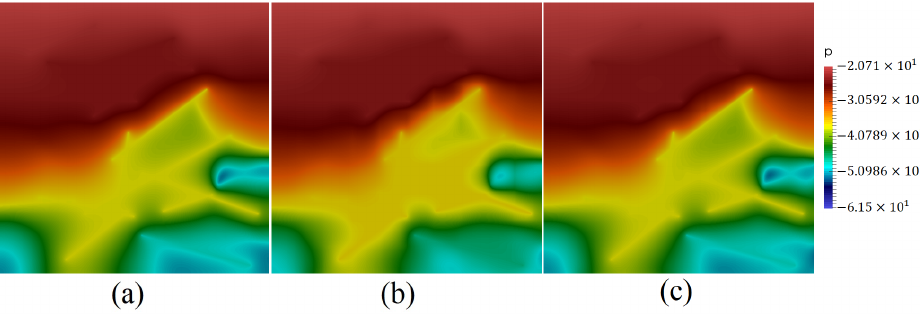
Figure 7. Numerical results for Test 2 . ( a ): fine grid solution. ( b ): multiscale solution using 3 offline basis functions. ( c ): multiscale solution using 3 offline basis functions and 1 online basis functions. Table 2. Numerical results for Test 2 . Relative L 2 and energy errors (%) for different number of offline multiscale basis functions using 1 and 2 online basis functions on the last time layer. Offline Basis 1 Online